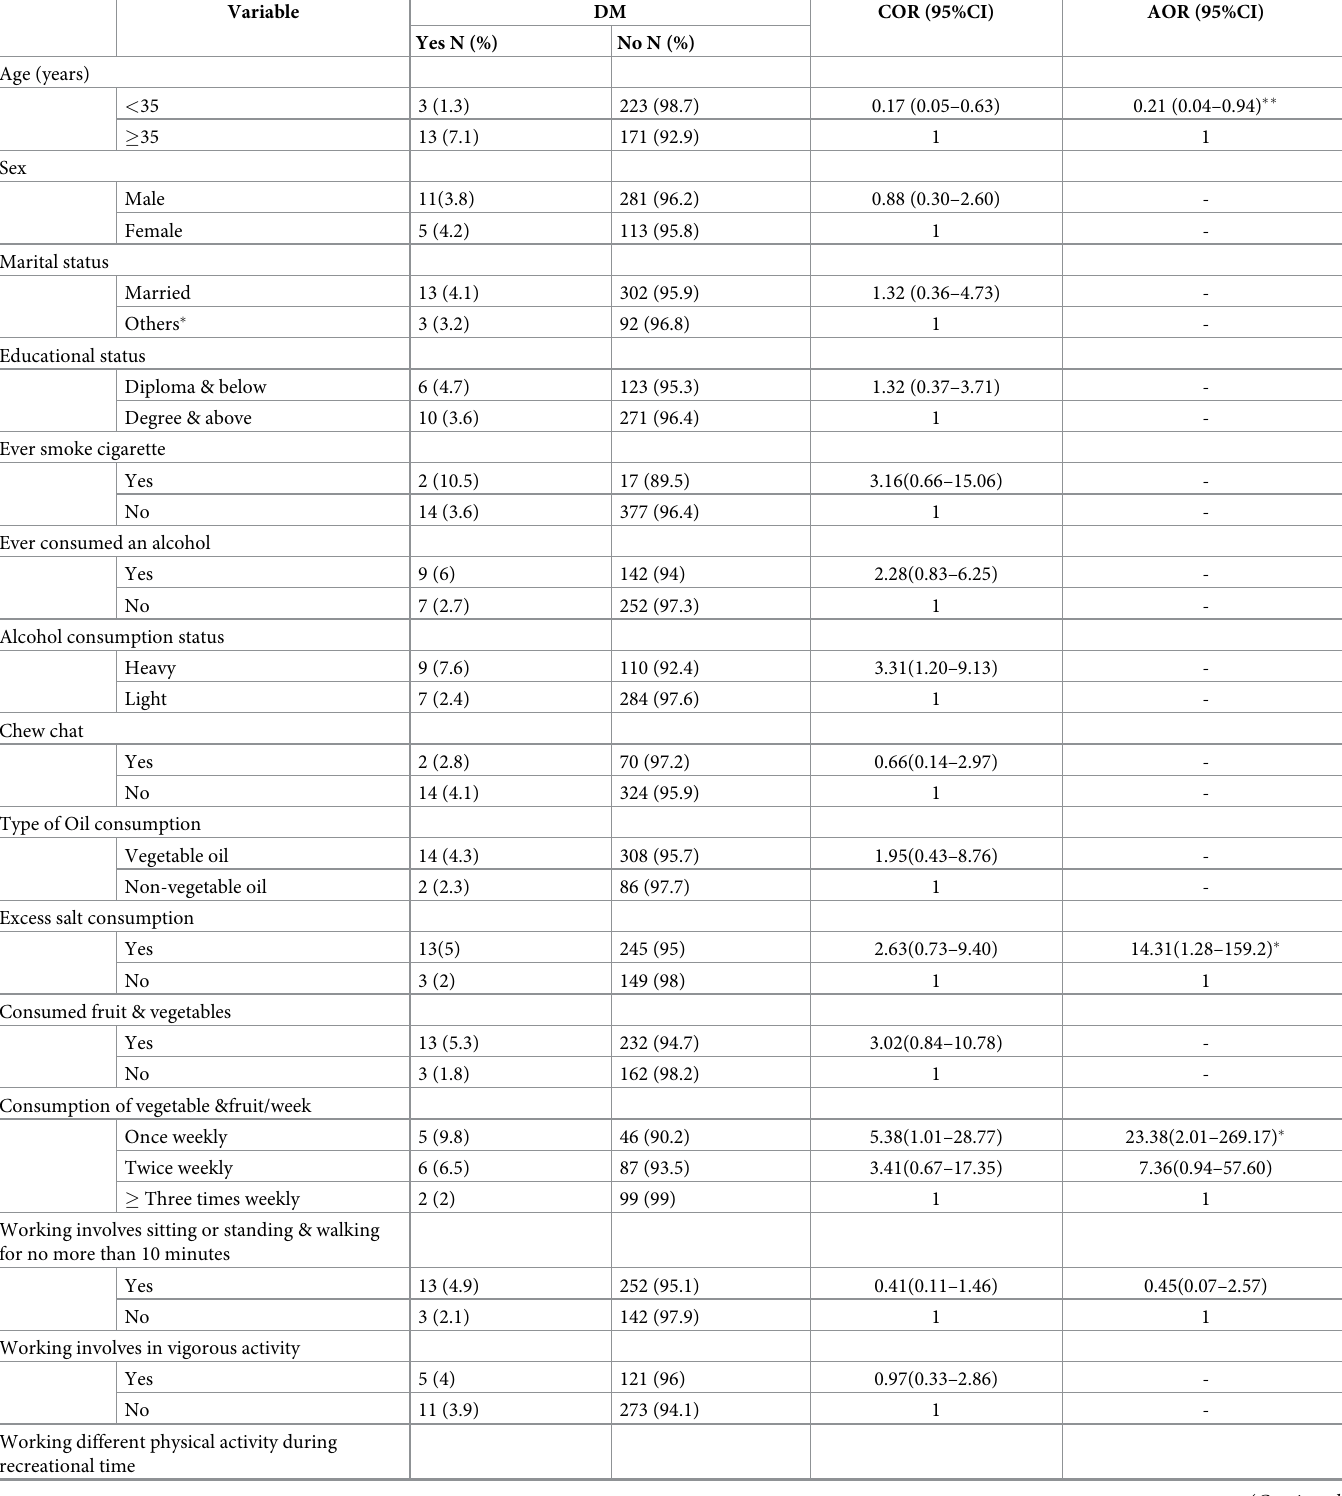
Table 5. Factors associated with magnitude of DM among the governmental employees at East Guji Zone, Southern Ethiopia,